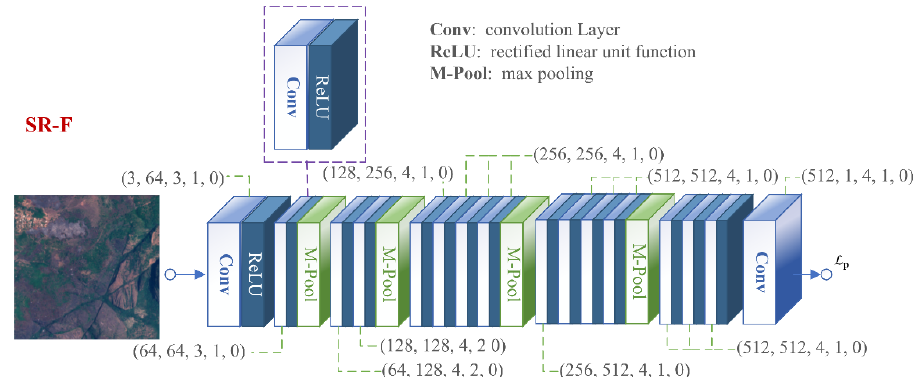
Figure 9. Structure of the perceptual-feature extractor (SR-F).